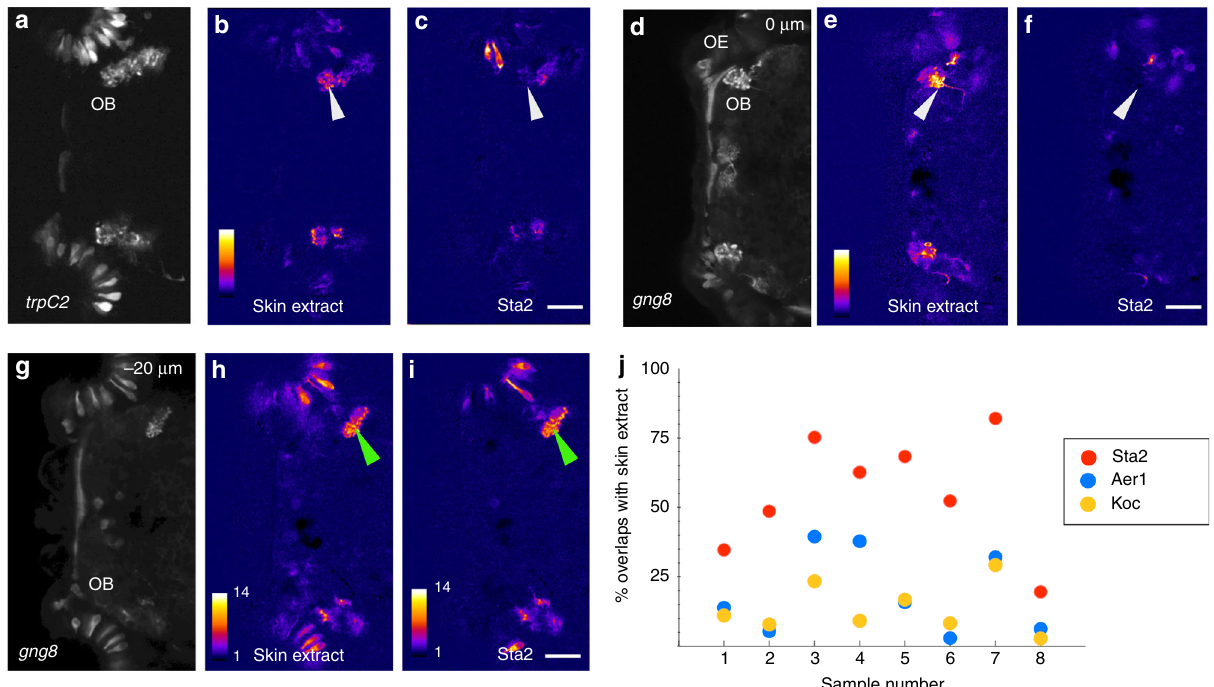
Fig. 5 Effect of bacterial lysate on the olfactory system. a – i Calcium imaging of the olfactory bulb two different larval fi sh exposed to skin extract ( b , e , h ) or bacterial lysate ( c , f , i ). Average projection of the time-series, showing GCaMP6s expression in olfactory sensory neurons and in terminals, driven by the trpc2 ( a ) or gng8 ( d , g ) promoter. Panels d – i are the same fi sh, with g – i showing a plane that is 20 µ m deeper than d – f . A glomerulus in the dorsal bulb (white arrowhead) is activated by skin extract but not by the bacterial lysate. Both lysates activate identical terminals in the ventral bulb (green arrowhead). j Percentage of overlap between response to three different bacterial lysates and skin extract. The highest overlap is seen with lysate from Staphylococcus sp. ZWU0021. Anterior is to the left; OB olfactory bulb, OE olfactory epithelium. Scale bar = 25 µ